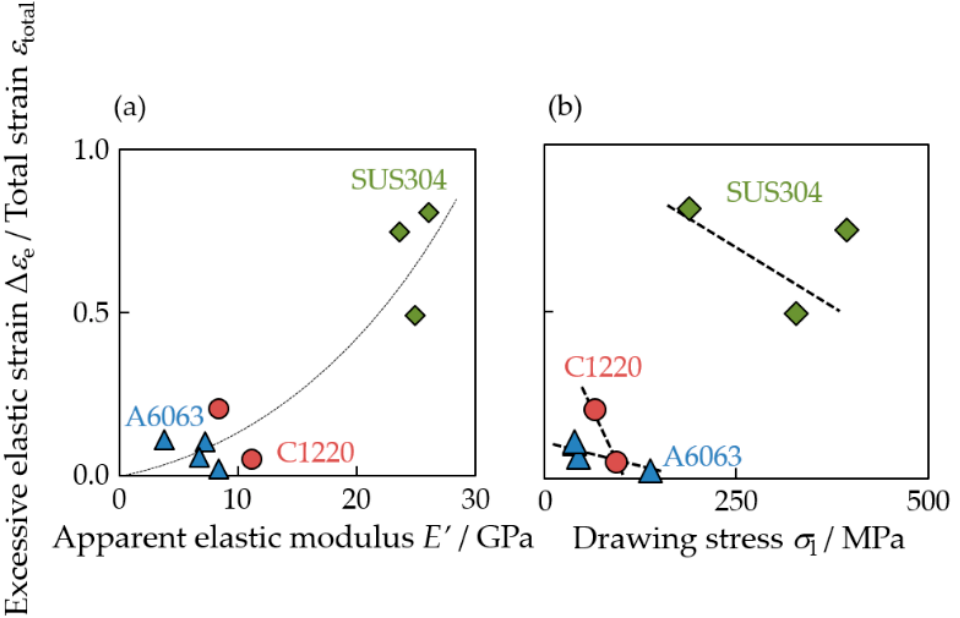
Figure 20. Relationship between the excessive elastic strain ∆ ε e and ( a ) the apparent elastic modulus E ’, ( b ) drawing stress σ l . The dotted curve and line indicate the eye guide.